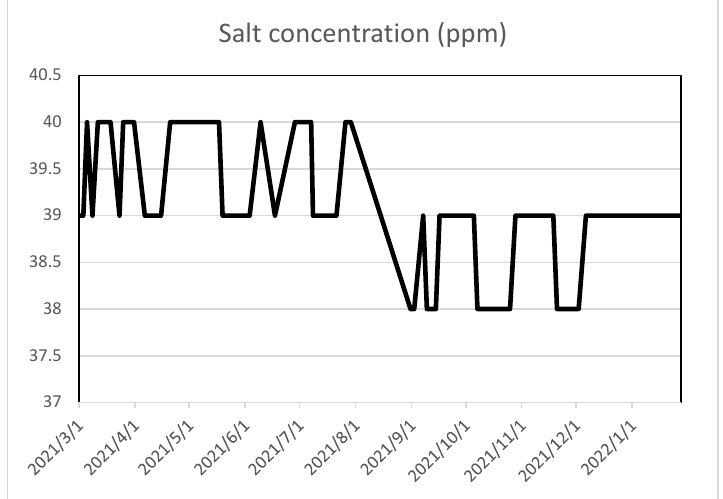
Figure 7. Oxidation-Reduction Potential results from the South Basin Barcelona port water. Source: The authors. As mentioned before, for the case of pH levels, variations observed in the Oxidation- Reduction Potential value were mainly due to the frequency of ships calling into the South Basin of the Barcelona port using open-loop scrubbers, and due to the frequency of pre- cipitation.